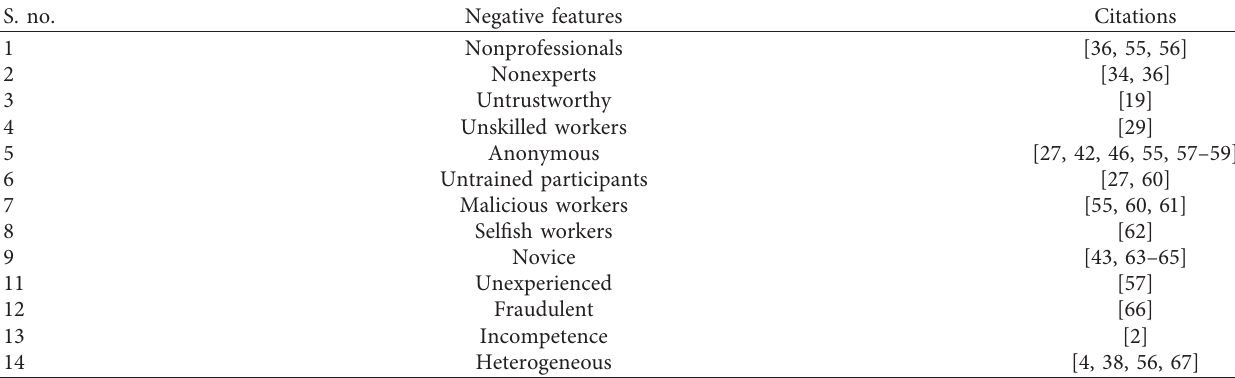
Table 2: Representation of negative features crowd features.